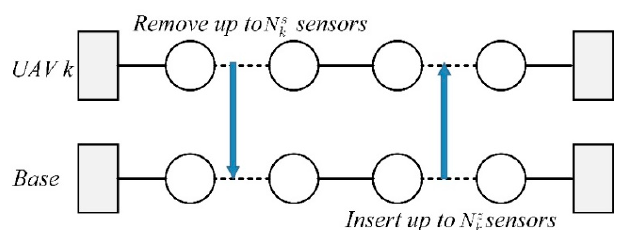
Figure 3. An example of an unbalanced exchange operator. Table 1. The shaking neighborhood structures.